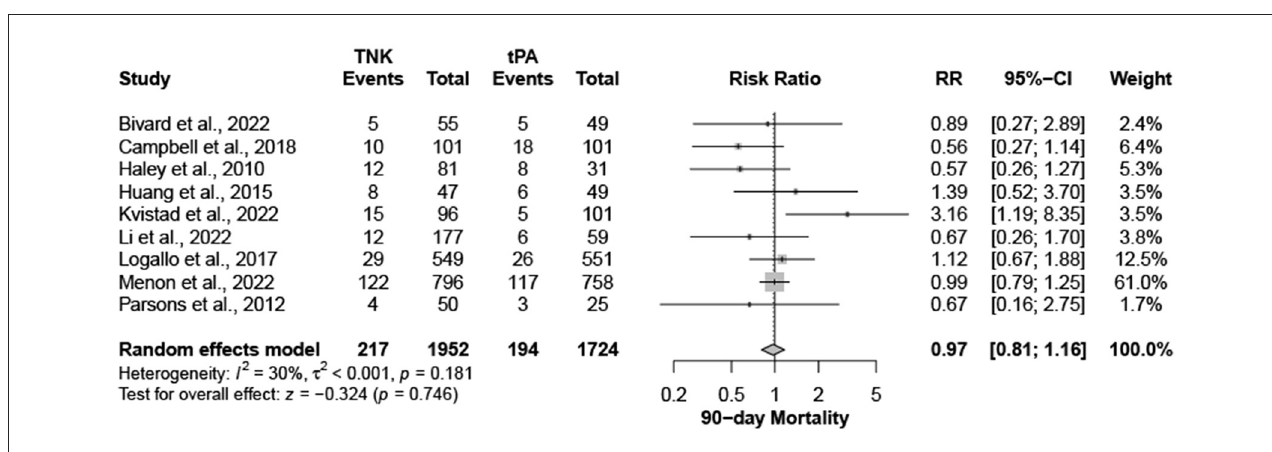
was significant heterogeneity for mRS 0–2 rates (I 2 = 71%; P - value = 0.002) (Figure 2). Similarly, mortality rates (RR = 0.97; 95% CI = 0.81–1.16; P -value = 0.746) and sICH rates (RR = 1.10;